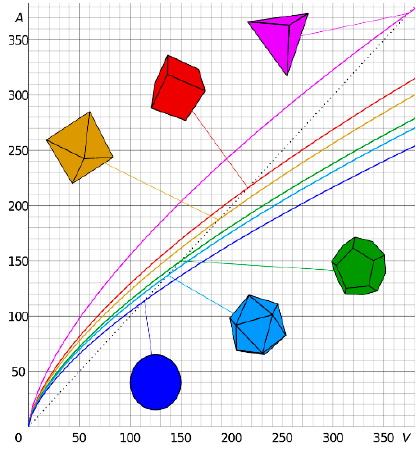
Figure 22. Curves showing that the ratio of surface area (vertical scale) to volume (horizontal scale) is smallest for pore spaces closer to spherical shapes and largest for pyramidal pore shapes. For any particular finite volume of fluid, the surface contact area with the pore wall varies with pore shape and in a non-linear fashion when pore volume increases.